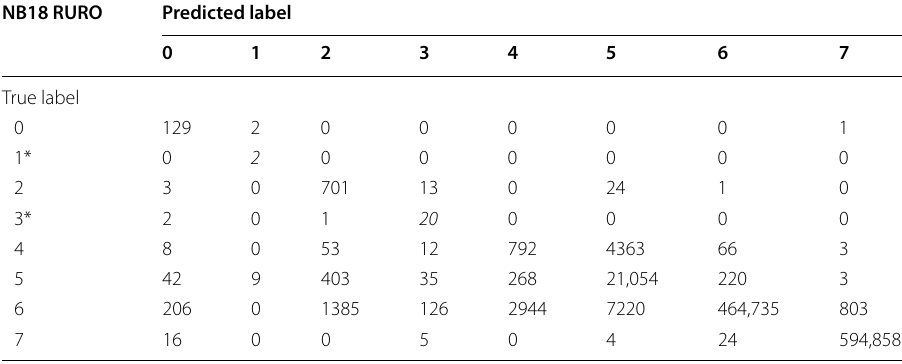
Table 34 Confusion matrix: NB18 RURO NB18 RURO